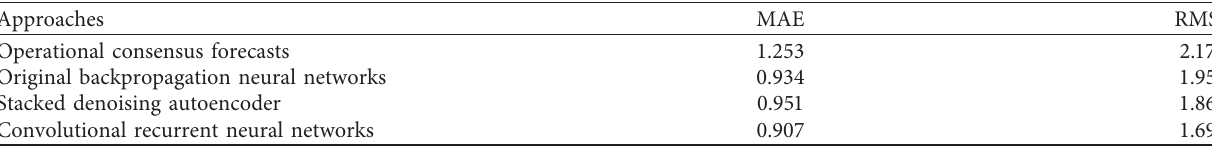
Table 2: Performance comparison with different approaches.